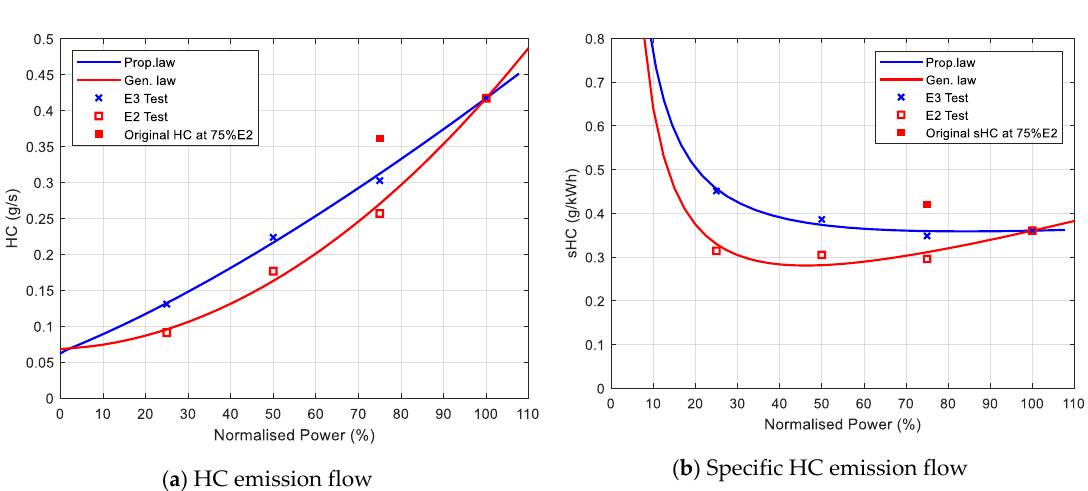
Figure A2. HC Figure A2. HC emission. Figure A2. HC emission.